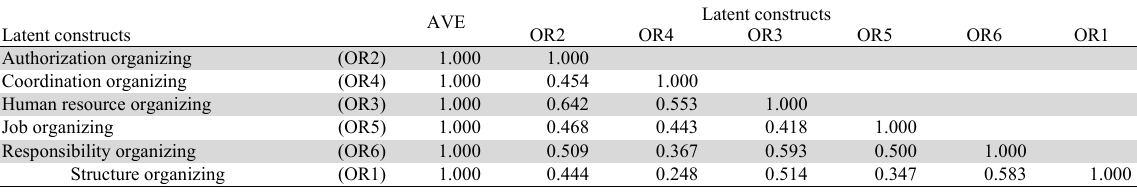
Comparison of square root of average variance extracted (AVE) and correlation coefficients between constructs Latent